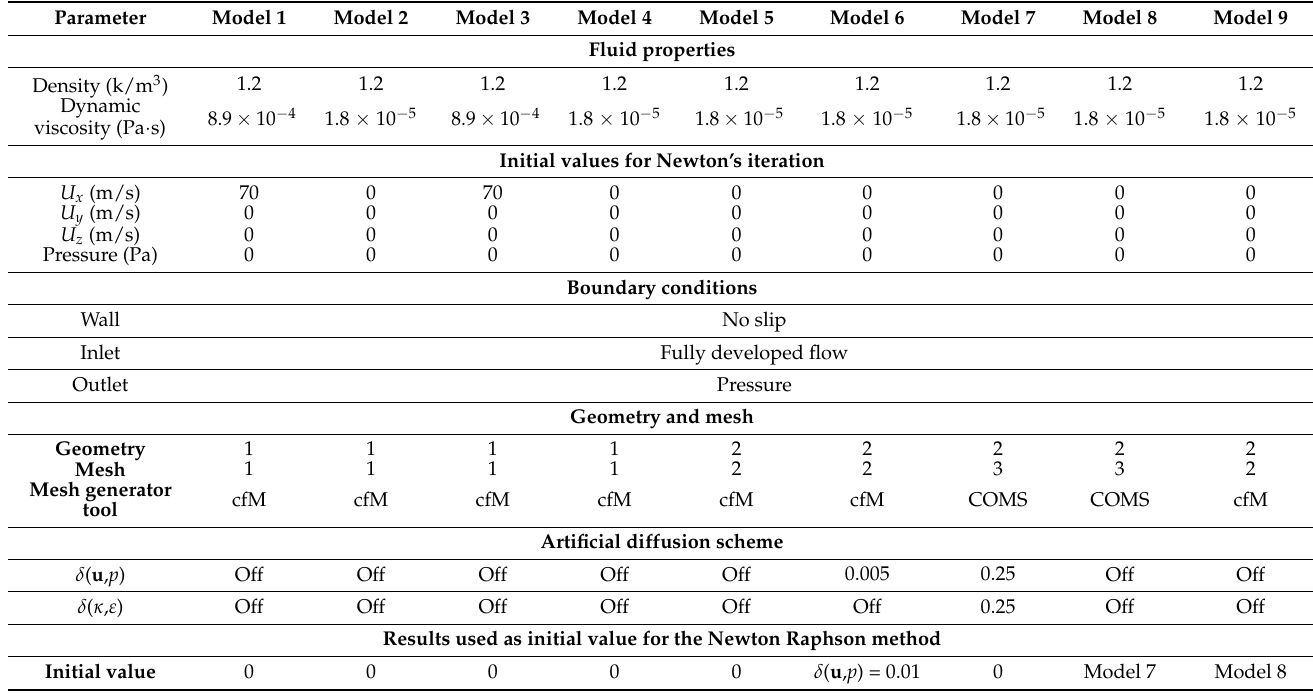
Table 2. Parameters used for the different